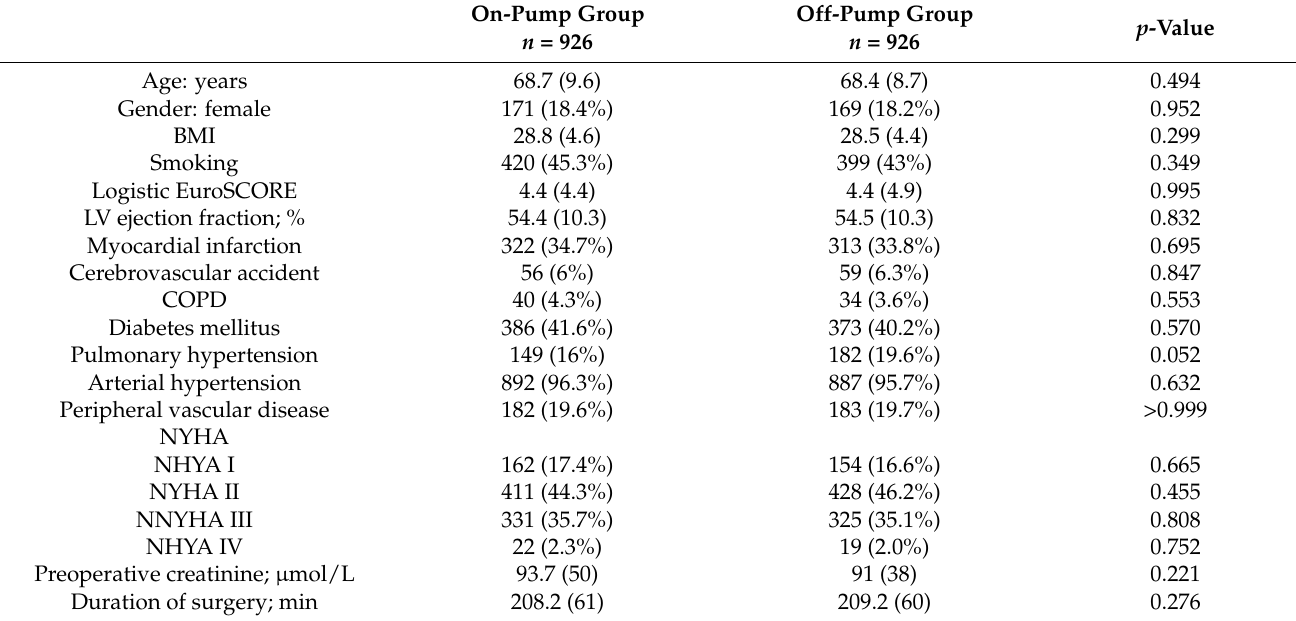
Table 1. Baseline characteristics and operative data for patients included in the study. Values are the mean (SD) or number (%).